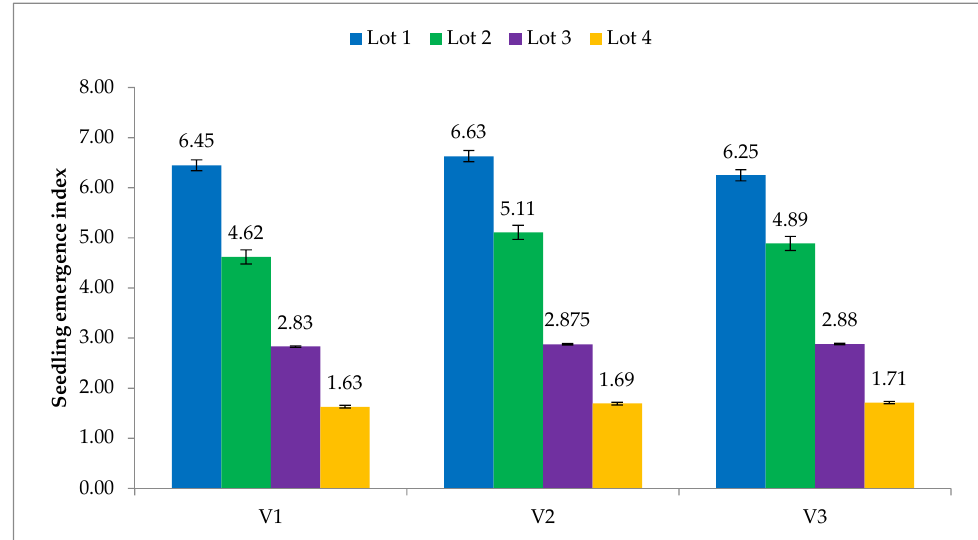
Figure 6. Effect of seed ageing on seedling emergence index. V 1 —Hisar-2; V 2 —Hisar Onion-3; V 3 —Hisar Onion-4; Lot 1—Fresh seed; Lot 2—One-year-old seed; Lot 3—Two-year-old seed; Lot 4—Three-year-old seed.